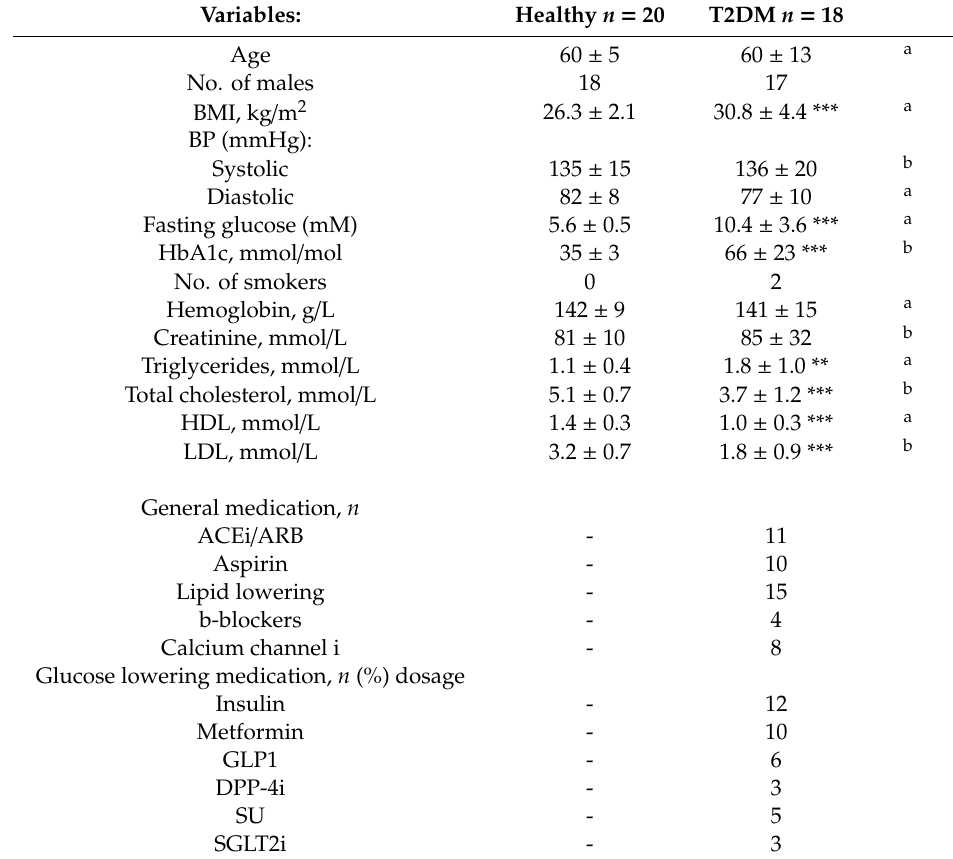
Table 1. Characteristics of healthy and T2DM